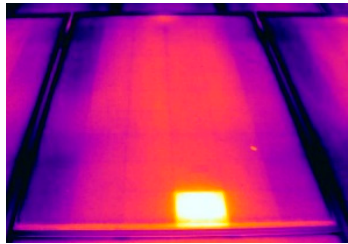
Figure 1. Thermographic image of a hot spot on the photovoltaic (PV) cell.